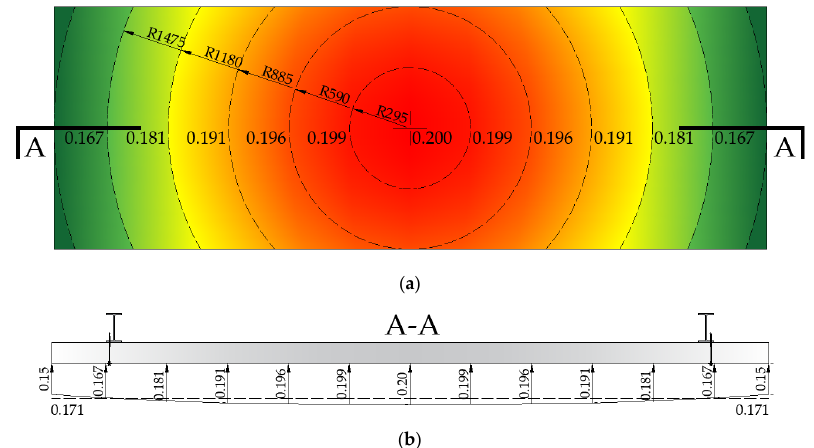
Figure 7. Variation of the overpressure ∆ p r in MPa on the front surface of a sandwich panel. ( a ) Front view. ( b ) Cross-section A-A view. The kinematical response of the sandwich panels subjected to the blast load was rec- orded using high-speed cameras. The selected frames recorded from Camera 1 (right col- umn) and Camera 2 (left column), for the specific times of the explosion, are presented in Figure 8. The vertical line at the backside of the panel was used to set the correct position for Camera 1.